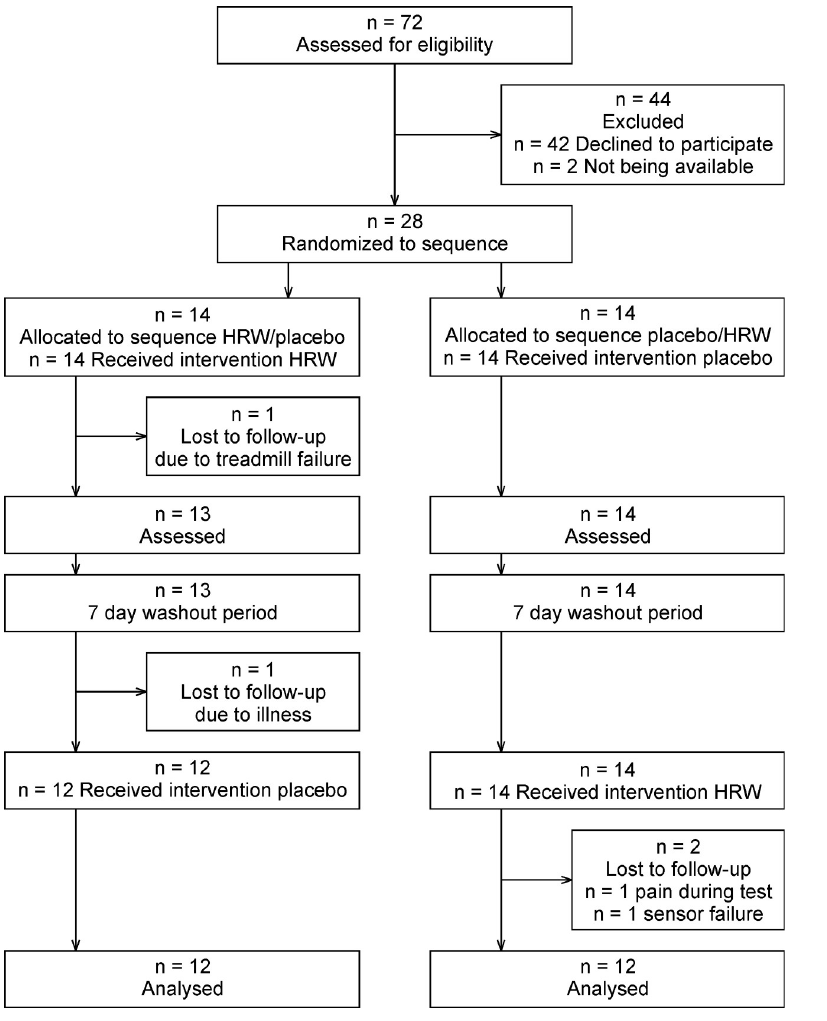
Fig 1. CONSORT flow diagram. HRW = hydrogen rich